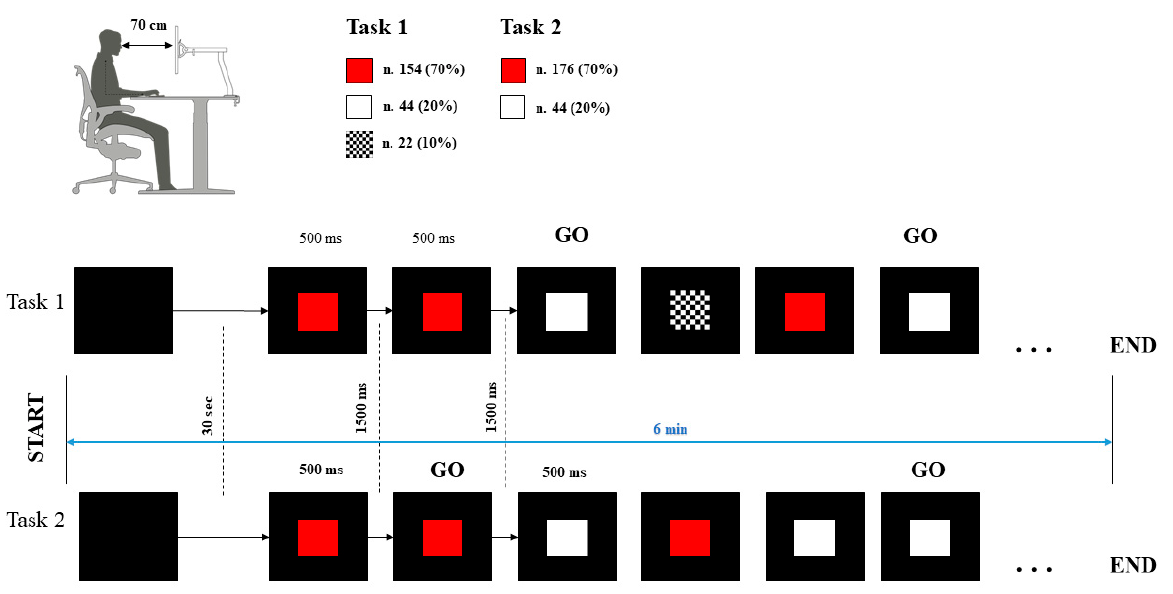
Figure 1. Experimental detail: The subject comfortably sits in front of the screen at 70 cm from the monitor with the hand positioned near the spacebar of the computer keyboard. In the first task, the subject must hit the spacebar when appearing the white square and stay to rest when the red square appears (the chess pattern with squares was the distractor). During the second task, the subject must hit the spacebar if the color of the square is the same as the previous square. The first square appeared after 30 s of a black image. The stimulus duration was 500 ms, and the interval of time between the stimuli was 1500 ms.